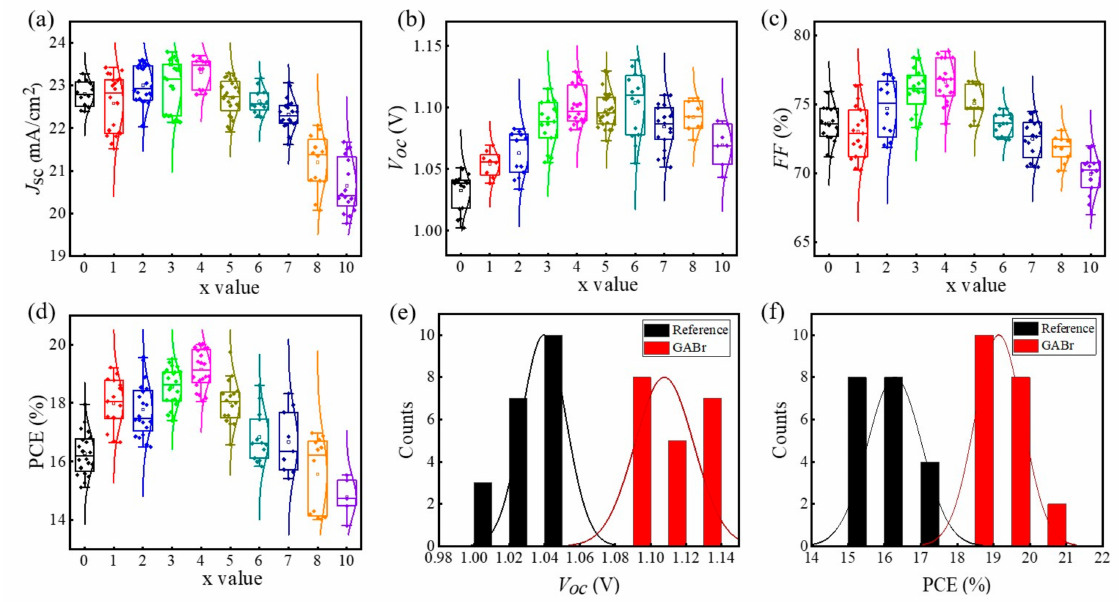
Figure 2. Statistical J-V parameters of ( a ) J sc , ( b ) V oc , ( c ) FF , and ( d ) PCE of devices modified by different concentrations of GABr. The histogram of ( e ) V oc and ( f ) PCE for reference devices and GABr-treated